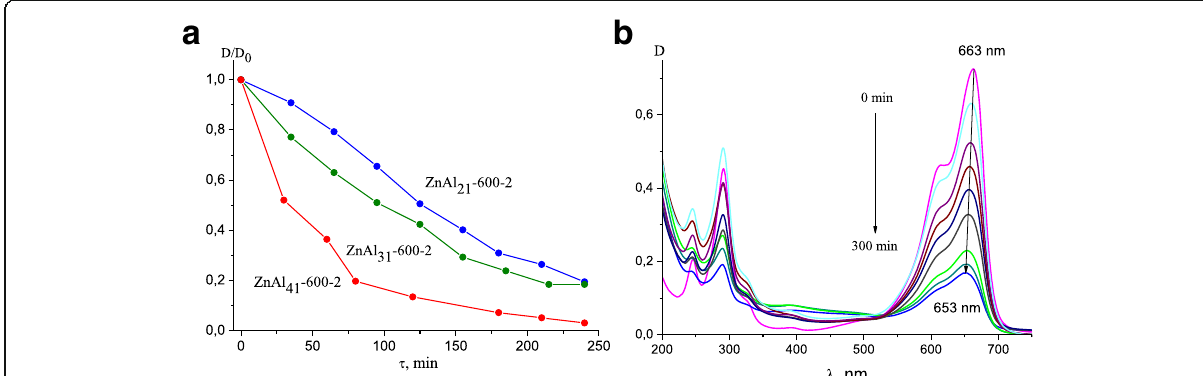
Fig. 5 Degradation curves of MB over calcined Zn-Al LDHs under UV-light irradiation ( a ); Absorption changes of 2*10 -5 M MB solution during the photodegradation process over ZnAl 31 -600-1 ( b )